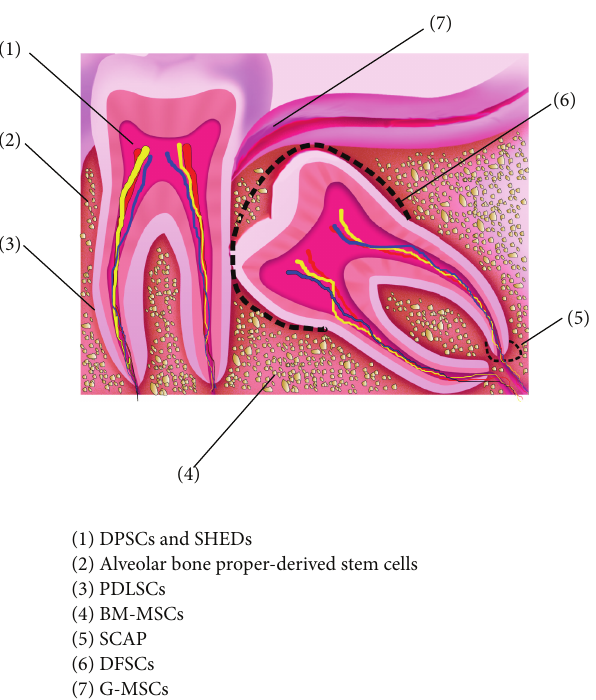
Figure 2: Sources of oral stem/progenitor cells isolated. DFSCs: dental follicle stem cells, G-MSCs: gingival mesenchymal stem/pro- genitor cells, PDLSCs: periodontal ligament stem cells, SHEDs: stem cellsfromthehumanexfoliateddeciduousteeth,DPSCs:dentalpulp stem cells, BM-MSCs: bone marrow mesenchymal stem cells, and SCAP: stem cells from the apical